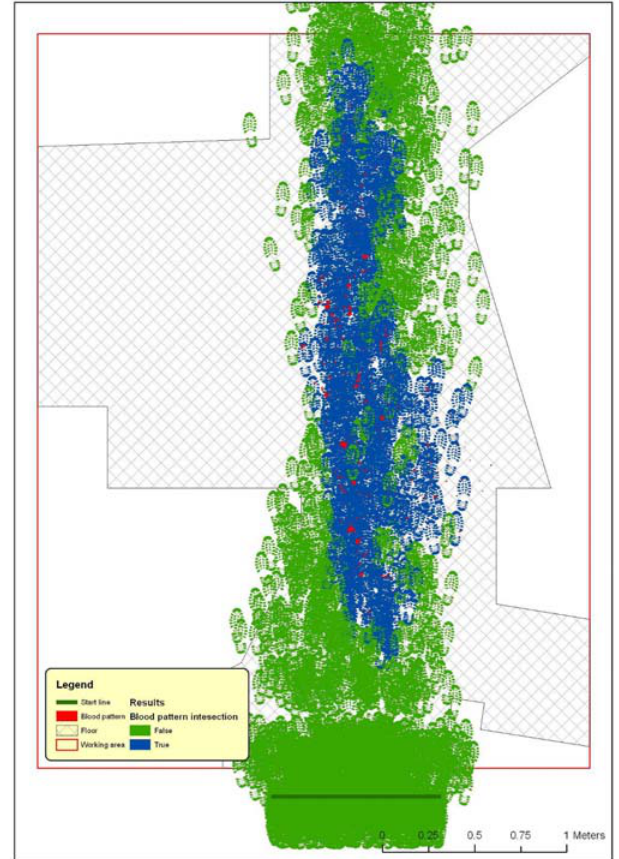
Figure 19 . Representation of the result of walk simulation